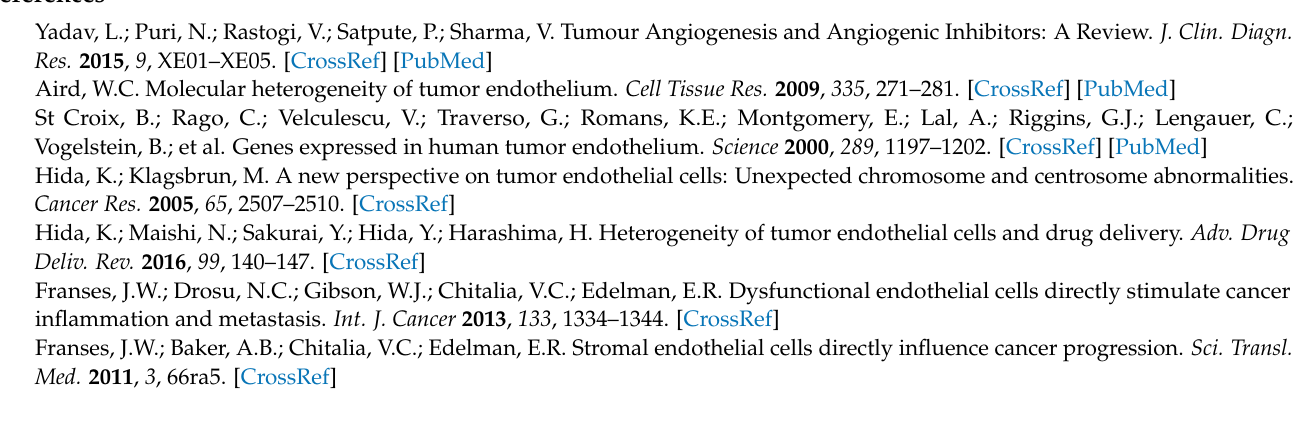
in HCC tissues, Figure S2: Down-regulation of endothelial Nogo-B expression facilitates cancer growth, Figure S3: Nogo-B silencing did not influence the apoptosis of endothelial cells, Figure S4: Nogo-B over- expression did not cause notable changes in HUVEC proliferation and migration, Figure S5: Endothelial Nogo-B does not influence Jak-STAT and MAPK signaling. Table S1: Clinicopathological factors of 167 HCC Specimens, Table S2: Univariate Analysis of Prognostic Factors, Table S3: Multivariate Analysis of Prognostic